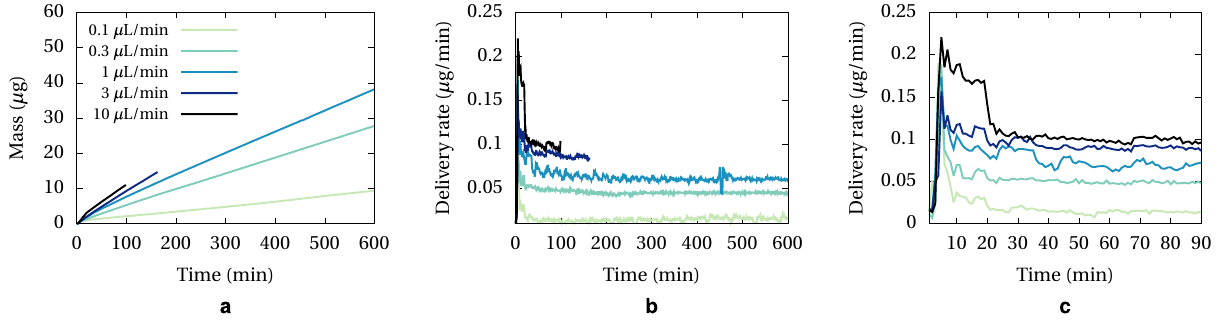
Figure 6. Delivery of methylene blue at various flow rates; ( a ) Mass measured in the image, accounting for probe shadow; ( b ) Delivery rate; ( c ) Detailed delivery rate in the 90 min.